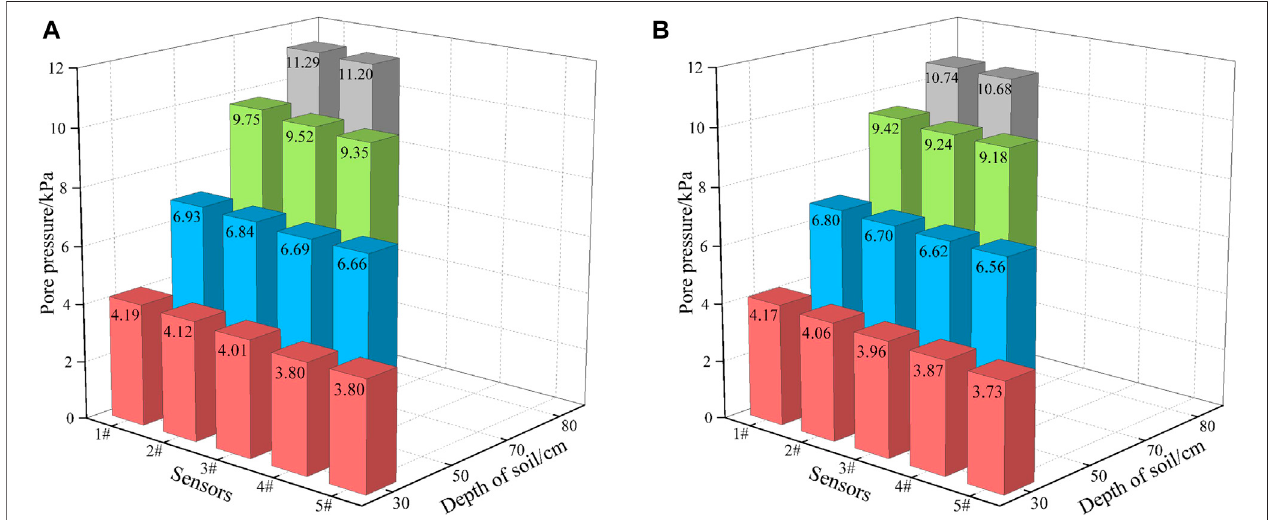
Frontiers in Materials |